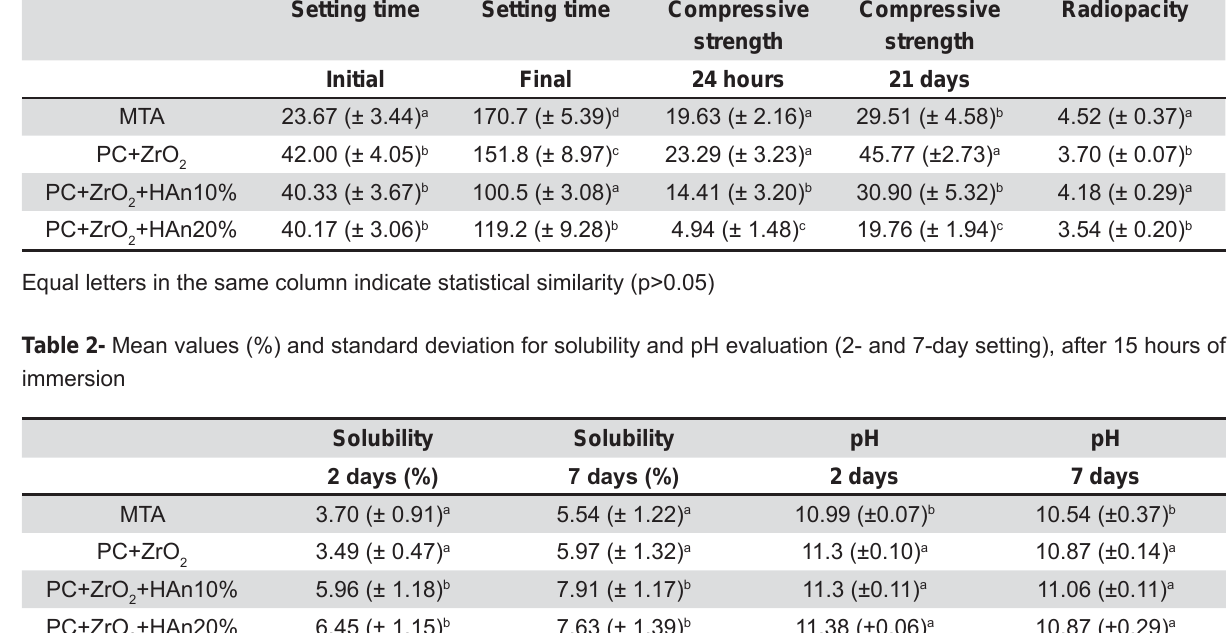
Equal letters in the same column indicate statistical similarity (p>0.05)